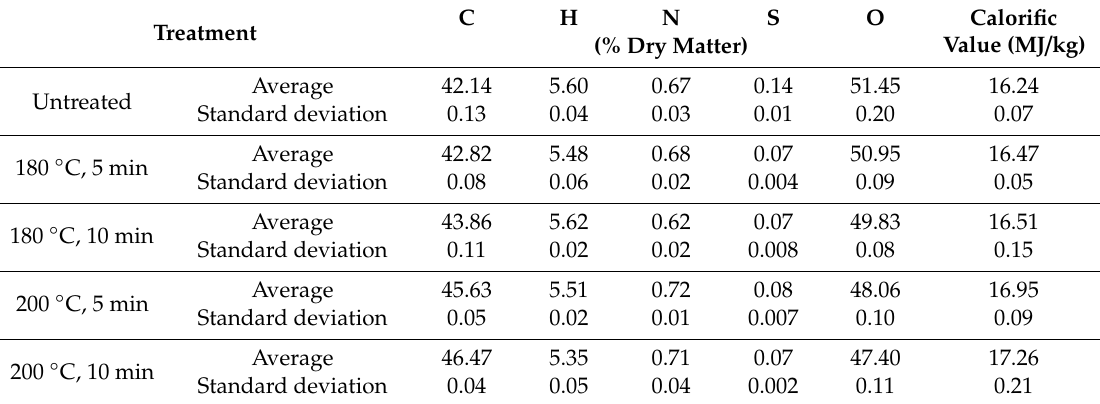
Table 1. Ultimate analysis and calorific value of untreated and steam treated rice straw.